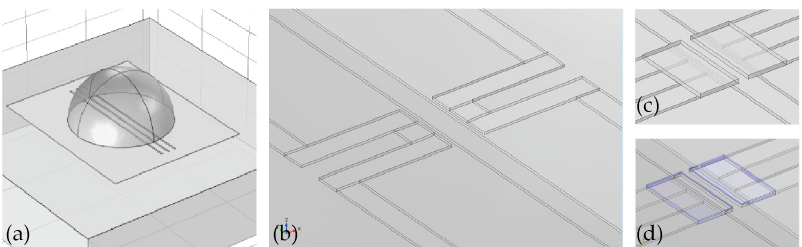
Figure 4. ( a ) Three parallel polysilicon strips are placed on the surface of silicon oxide, with the heater in the middle and two symmetric sensors on either side and ( b ) thermopile with the hot junction close to the heater and the cold junction away from the heater ( c ) metal pads connecting the heater and the hot junction and ( d ) coated metal